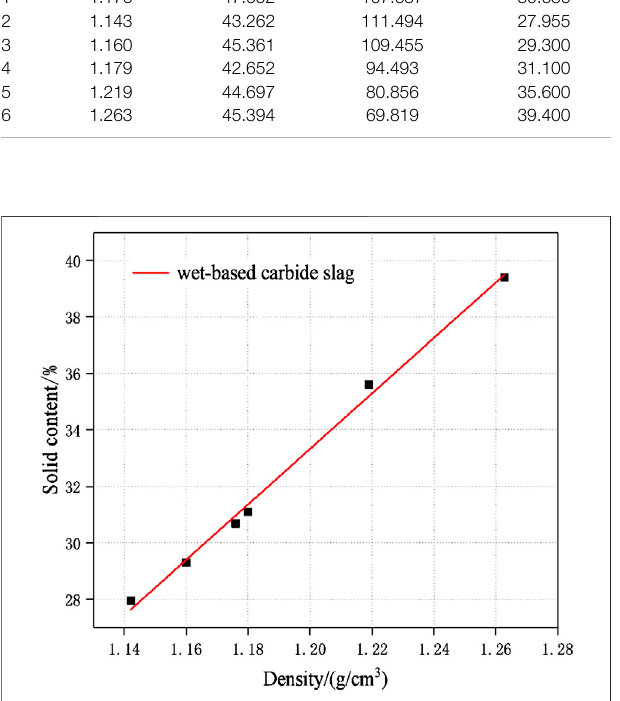
FIGURE 5 | Solid content-density curve of wet-based carbide